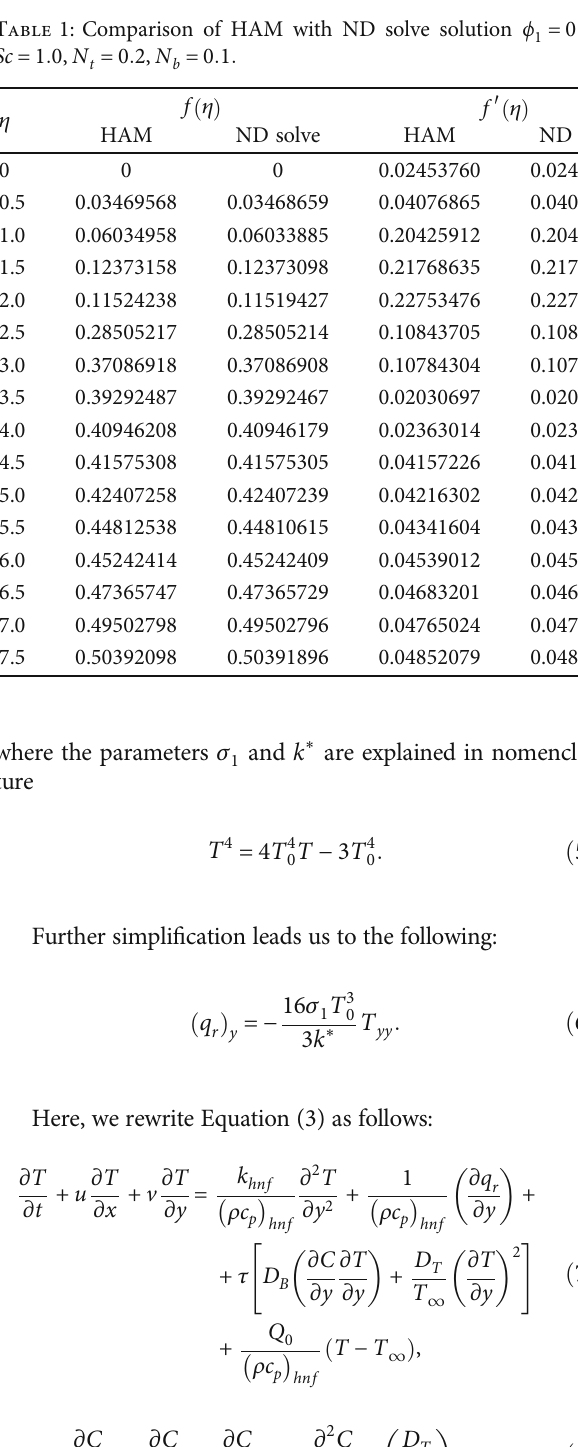
Table 1: Comparison of HAM with ND solve solution ϕ